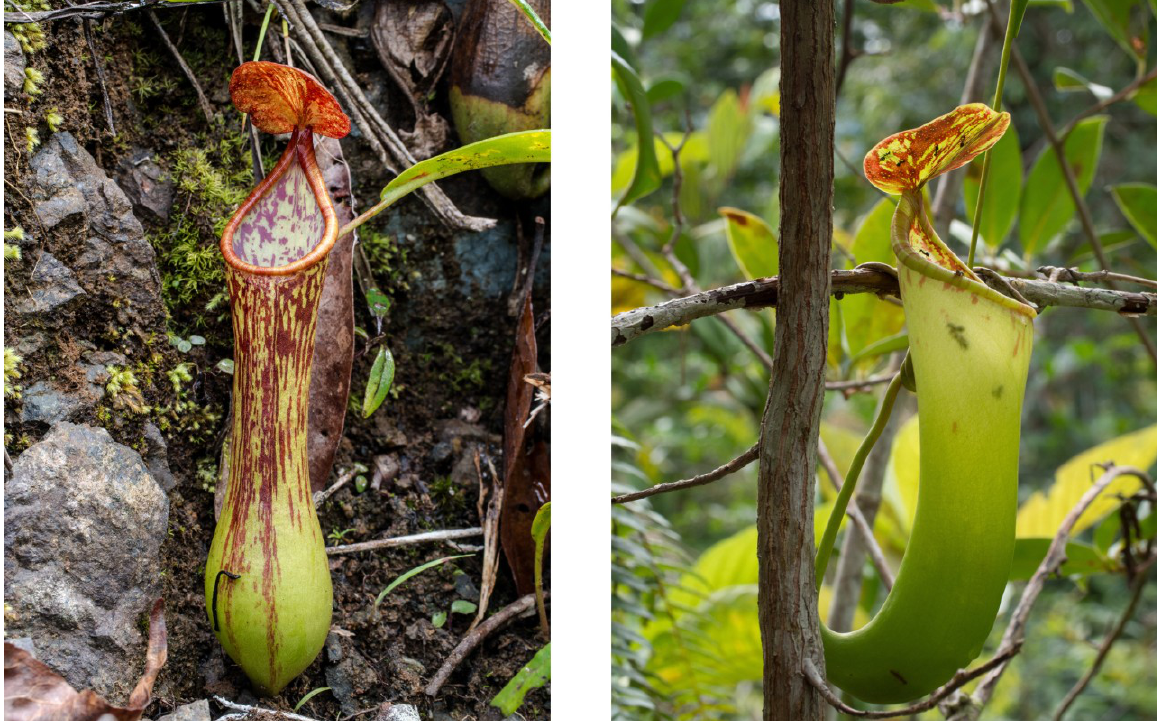
Figure A2. N. cornuta : photos of a lower ( left ) and upper pitcher ( right ) (with Crematogaster sp.) taken at the type locality.